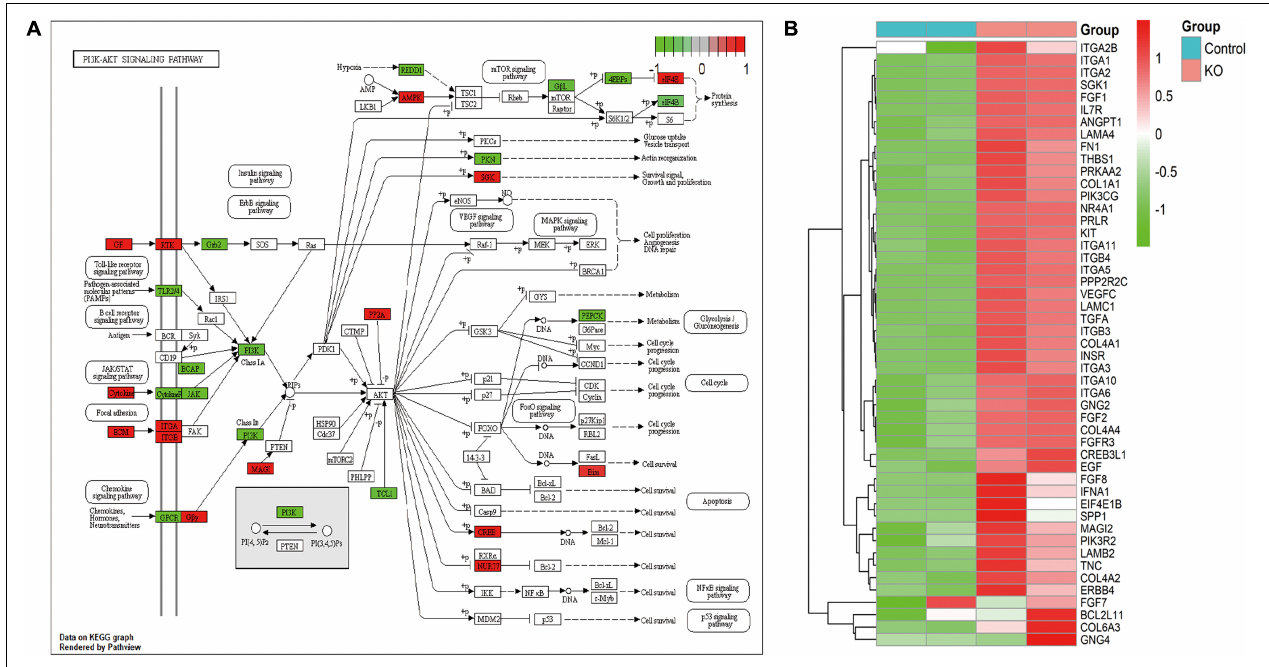
FIGURE 3 | PI3K-Akt signaling pathway for DEGs from knocking out U11. (A) PI3K-Akt signaling pathway diagram. (B) Heatmap from DEGs in this